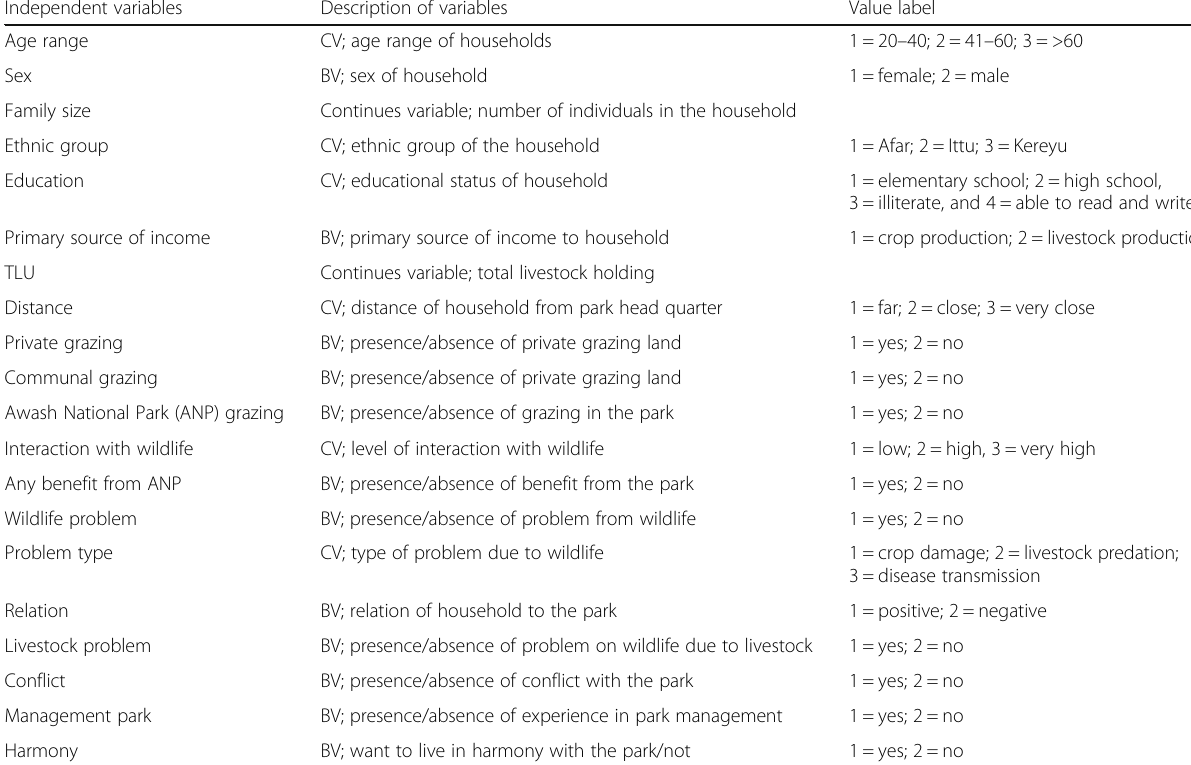
Table 1 Description of independent variables used in ordinal logistic regression model Independent variables Description of